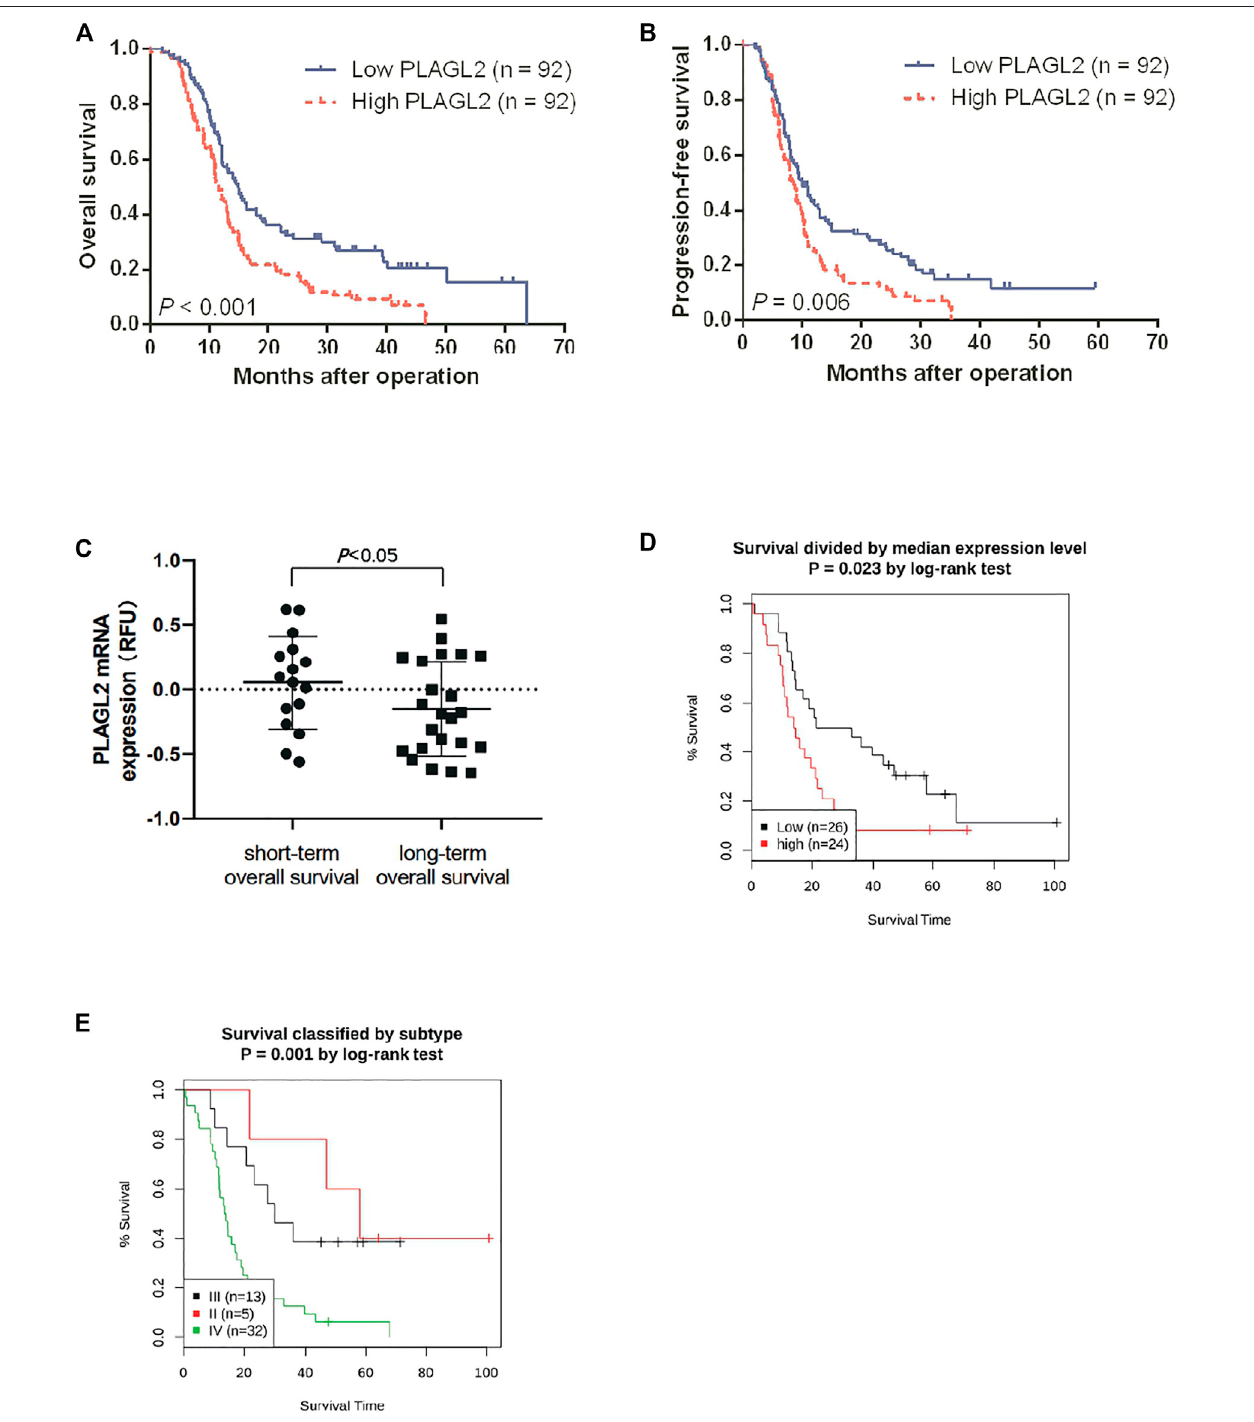
FIGURE 4 | Association between PLAGL2 expression and OS and PFS of HGG patients assessed by Kaplan – Meier survival curves and GENT2 database. (A,B) Patients with high expression had signi fi cantly shorter OS and PFS time than those with low expression, p < 0.001 and p < 0.01, respectively. (C) High PLAGL2 expression is associated with shorter OS time in GSE53733 ( p < 0.05). (D) Survival divided by PLAGL2 median expression level (log-rank test, p = 0.023) (E) Survival classi fi ed by subtype (log-rank test, p = 0.001).